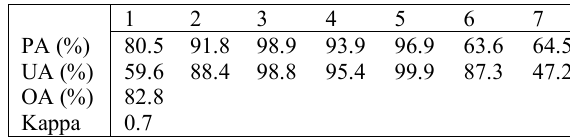
Table 6.2. Results obtained for 2019-year classification. PA: Producers Accuracy; UA: User’s Accuracy; OA: Total precision and Kappa classification.